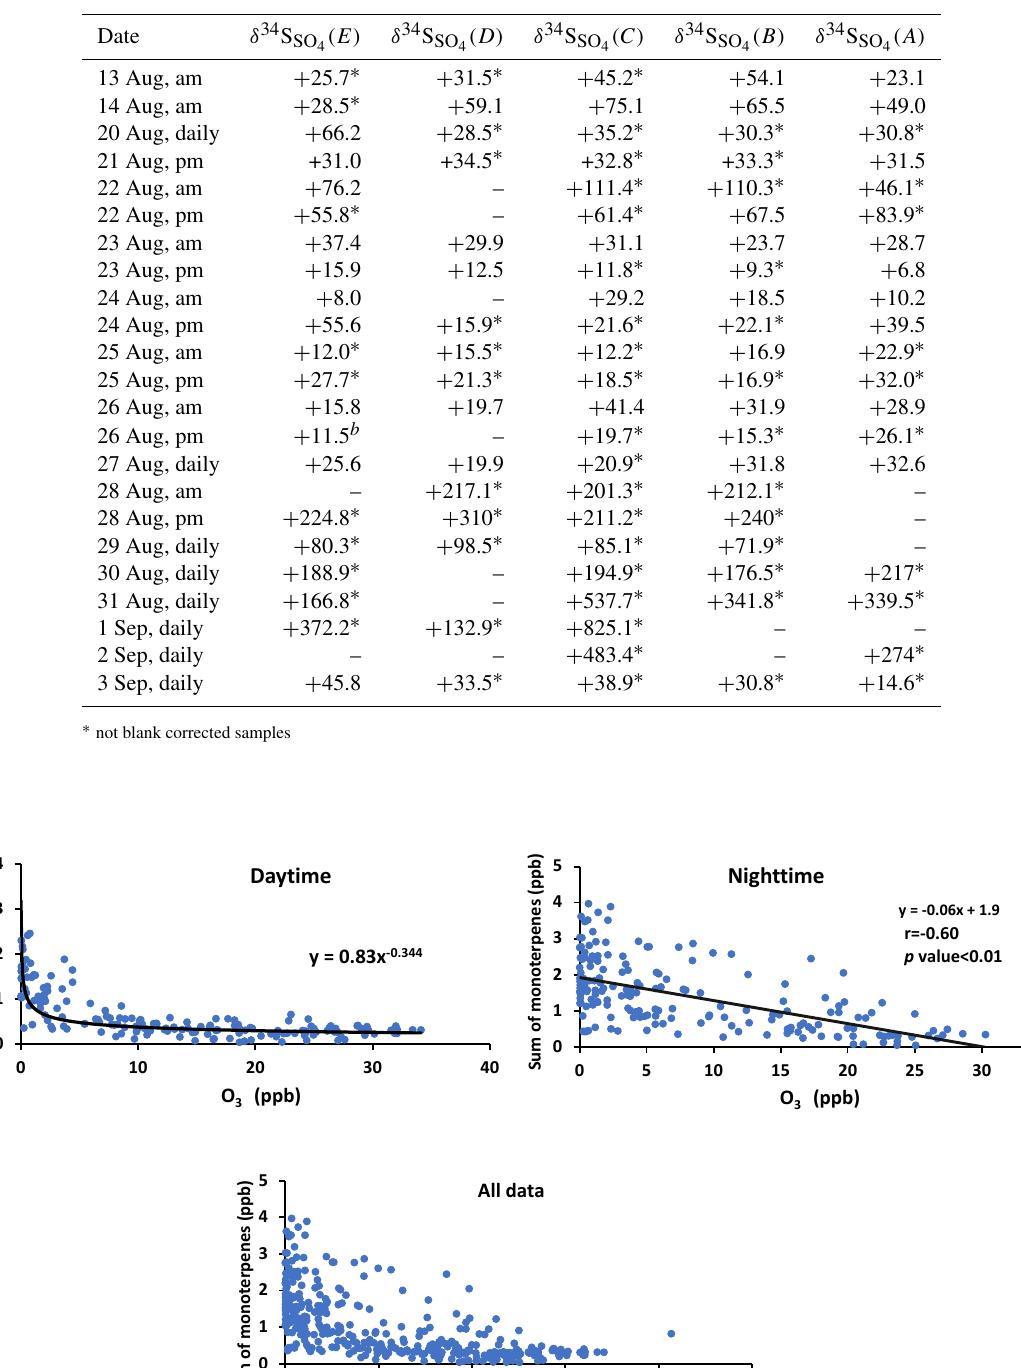
Table 3. δ 34 S (‰) values for sulfate in size ranges E 0 . 49 − 0 . 95µm , D 0 . 95 − 1 . 5µm , C 1 . 5 − 3 . 0µm , B 3 . 0 − 7 . 2µm , and A > 7 . 2µm during CIMS-ON periods. Average uncertainty for δ 34 S values is ± 0.5‰.